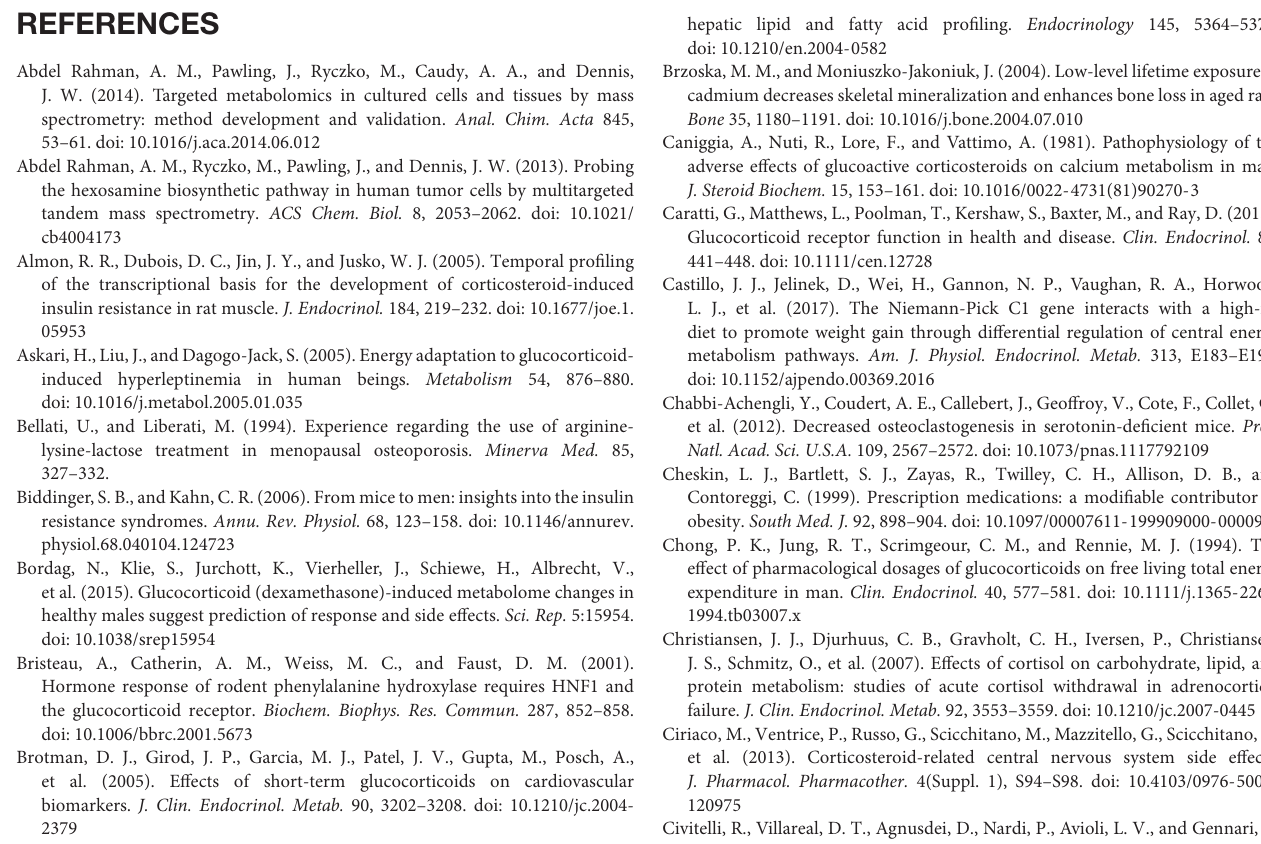
FIGURE S1 | Box plots and kernel density plots before and after normalization. The boxplots show ∼ 50 features due to space limitations. The density plots are based on all samples. Selected methods: Row-wise normalization: Normalization to the constant sum; Data transformation: Log Normalization; Data scaling: Pareto Scaling. TABLE S1 | List of metabolites and their optimized LC/MS parameters. ∗ Internal standards. TABLE S2 | Important features identified by volcano plot